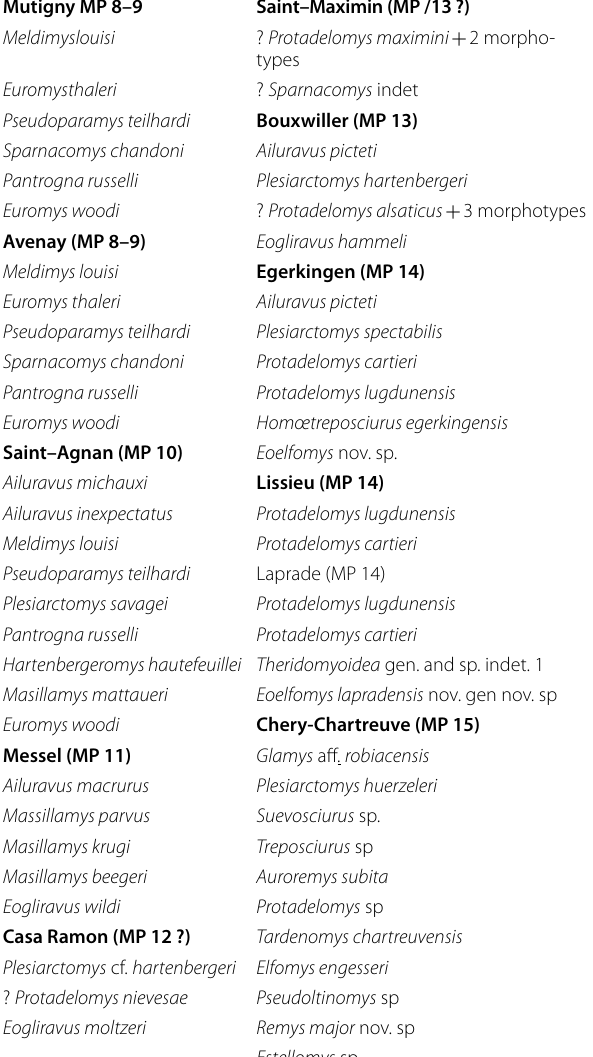
Table 9 Lists of rodents’ species from middle and upper